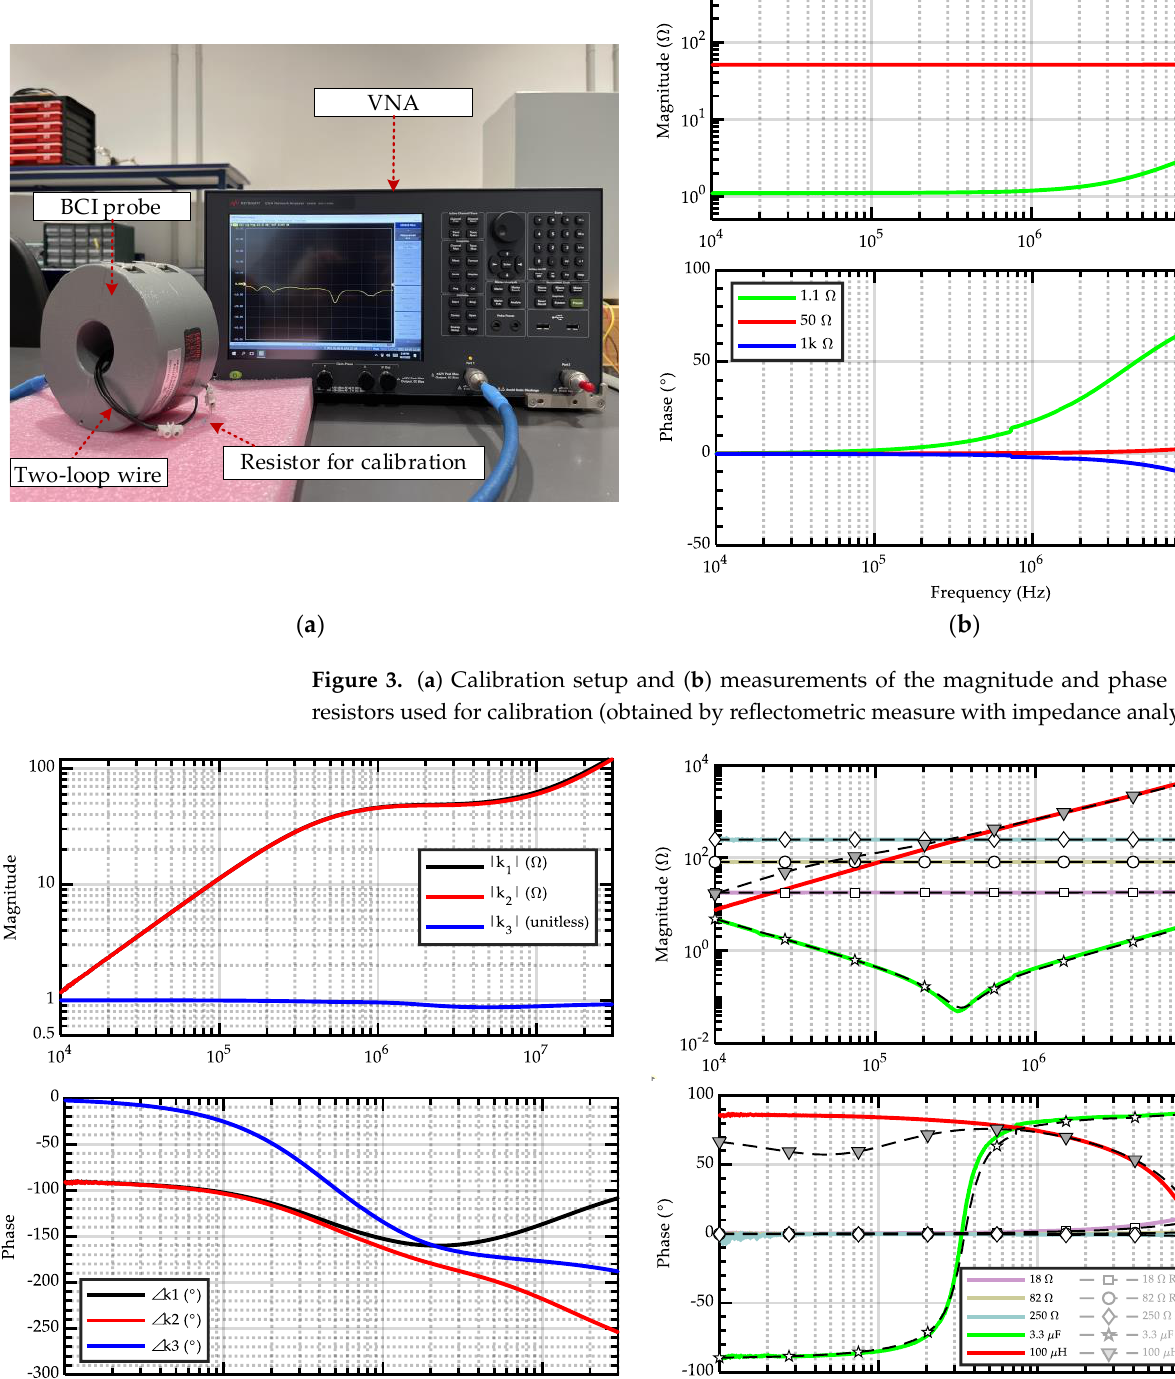
Figure 3. ( a ) Calibration setup and ( b ) measurements of the magnitude and phase of the three resis- tors used for calibration (obtained by reflectometric measure with impedance analyzer).